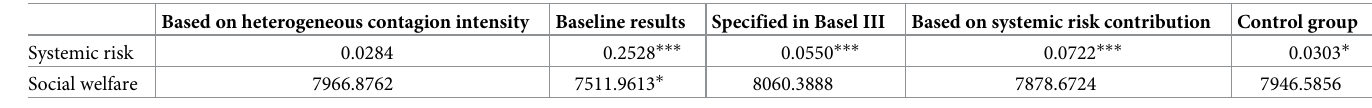
Table 8. Auxiliary statistical results of different capital requirements.